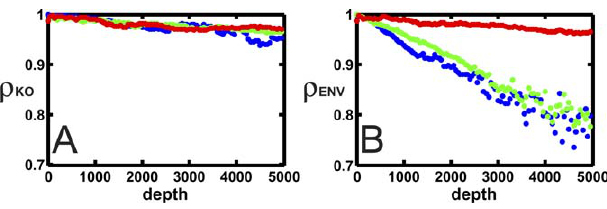
Figure 7. Evolution of Robustness (A) Node removal ( q KO ) and (B) environmental ( q ENV ) robustness along the line of descent for a static (green), quasi-static (blue), and a dynamic (red dots) environment as a function of phylogenetic depth.